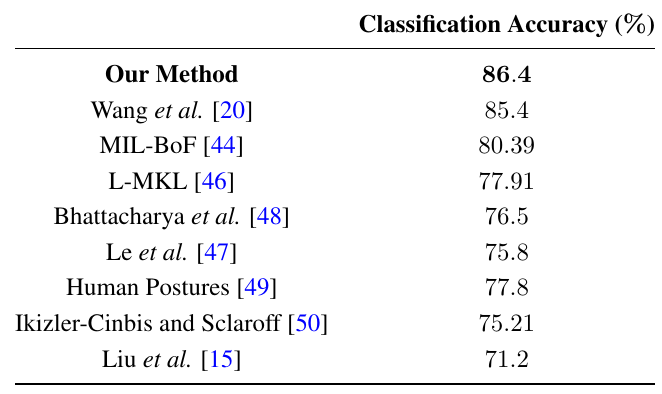
Table 2. Performance comparison of the proposed GPMK with previous methods in action classification literature (Youtube [15]).